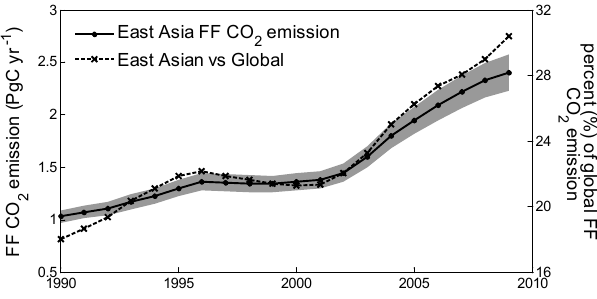
Fig. 1. Change in fossil fuel CO 2 emissions (FF CO 2 emission) over East Asia and its relative contribution to global fossil fuel CO 2 emissions, from 1990 to 2007. Data acquired from IEA statistics. Grey area shows 1-sigma standard error of the fossil fuel CO 2 emis- sion